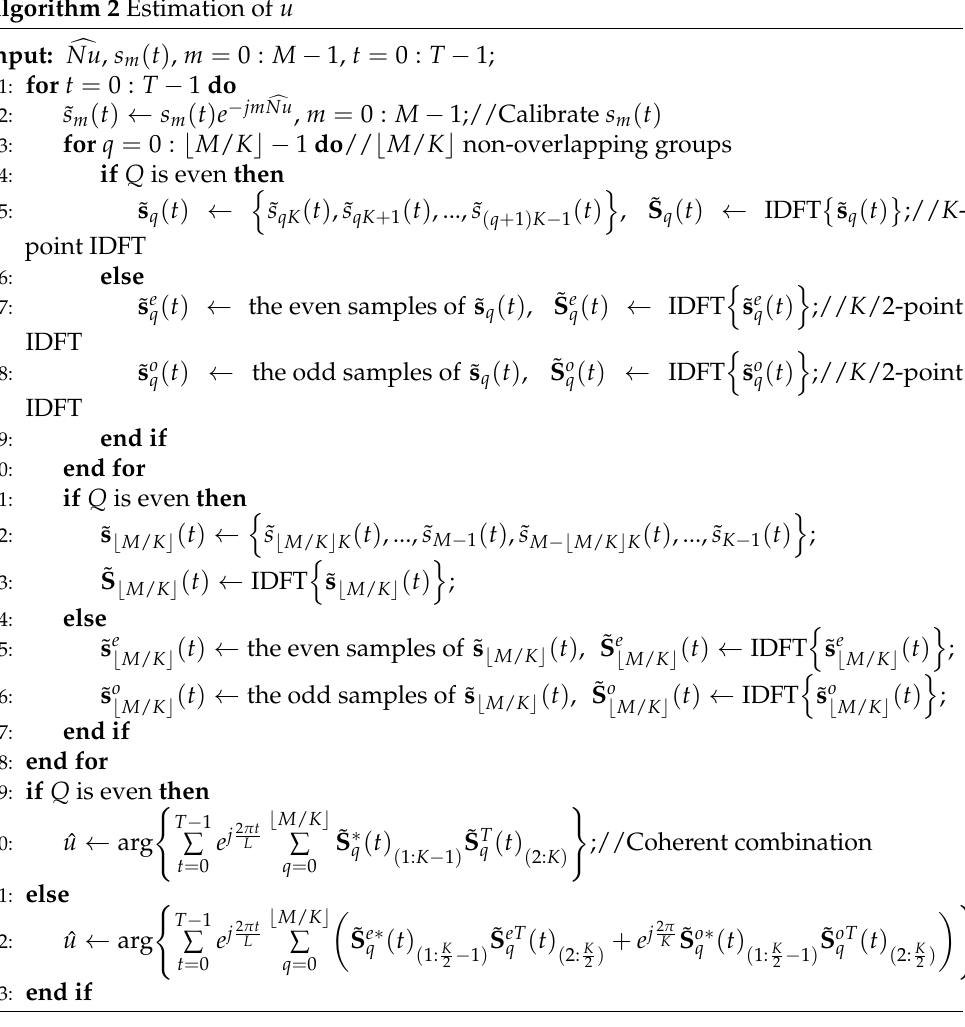
Algorithm 2 Estimation of